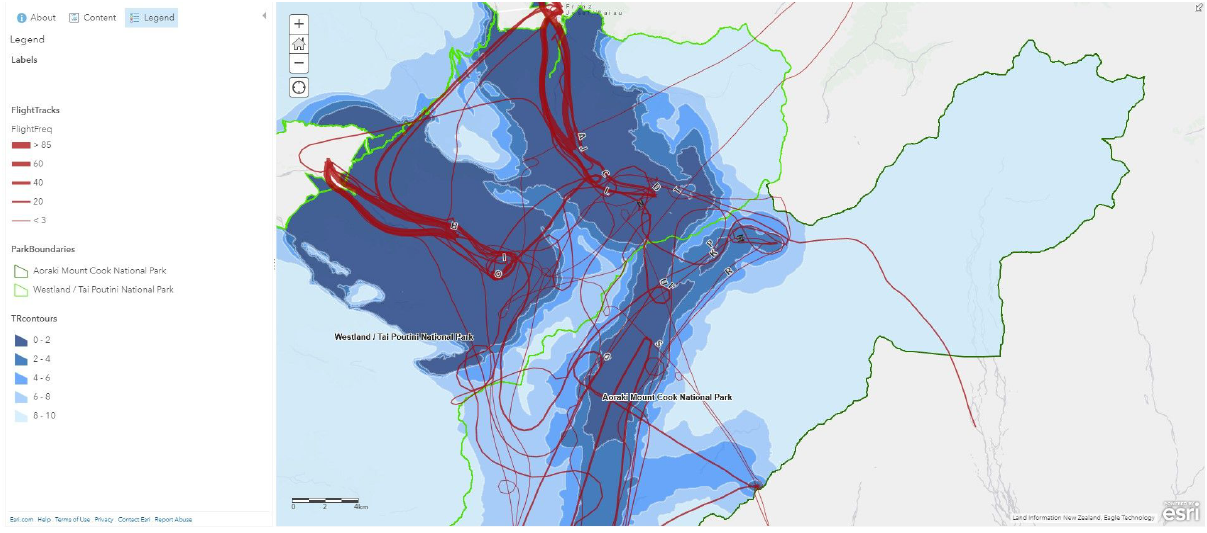
Figure 7: Interactive Web Map showing hours of excellent tranquillity (TR ≥ 8)